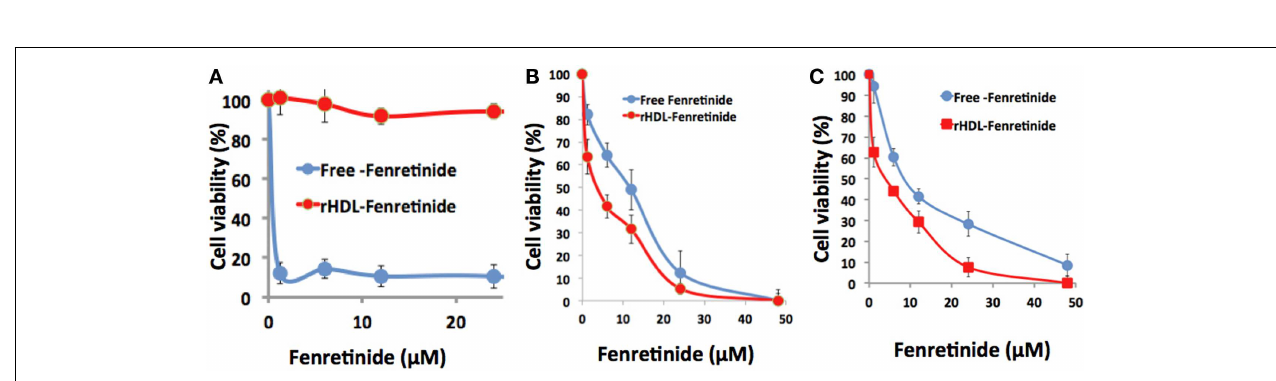
FIGURE 6 | Differential cytotoxicity of free fenretinide vs. the rHDL encapsulated drug against non-malignant,ARPE-19 cells (A) and two neuroblastoma cell lines SMS-KCNR (B) and SK-N-SH (C).